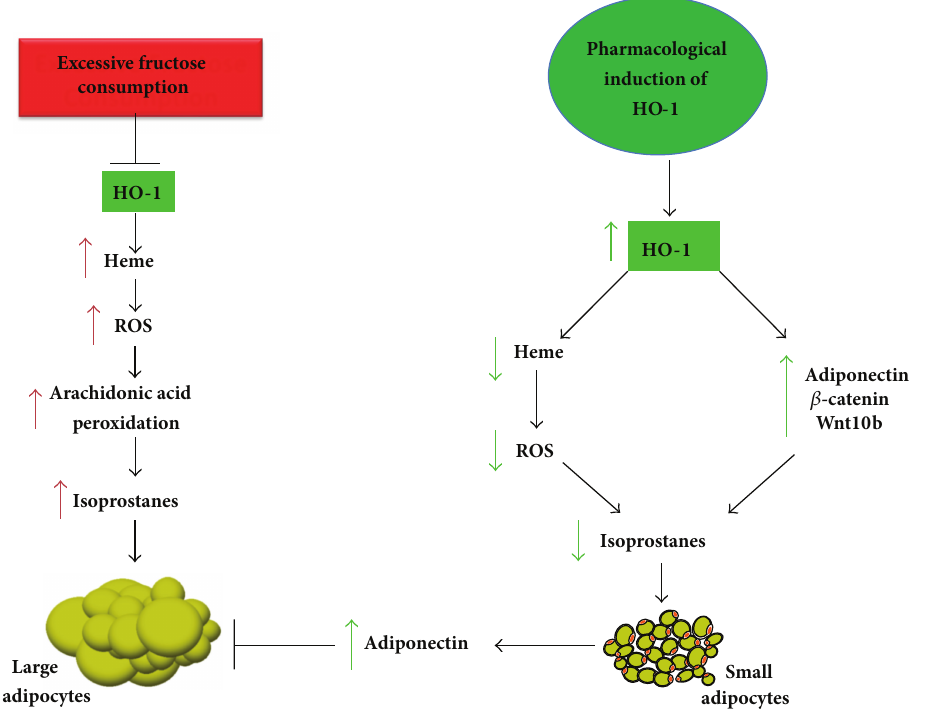
Figure 9: Schematic diagram of fructose-mediated adipocyte expansion and potential mechanisms underlying HO-1-mediated improvement of fructose-induced adipocyte hypertrophy. Excessive fructose consumption is accompanied by decreases in HO-1 gene expression and a concurrent increase in cellular heme levels. Increase in cellular heme results in lipid peroxidation of the essential fatty acid, arachidonic acid, via activation of ROS. The metabolite of this process is isoprostane and, therefore, heme catalyzes isoprostane synthesis. Isoprostane release induces adipocyte hypertrophy and dysfunction. In contrast, the increase in HO-1 expression and HO activity by pharmacological agents, for example, CoPP, leads to a decrease in the cellular heme pool and an increase in the canonical Wnt pathway and of adiponectin. Adiponectin enhances the antioxidant mechanisms, thereby decreasing lipid droplet size along with attenuation of isoprostane production. An increase in HO activity lowers lipid peroxidation, thereby decreasing isoprostane production and diminishing expression of the adipogenic markers Peg-1/Mest, FAS, and aP2, resulting in the lowering of adipocyte hypertrophy. Thus, activation of the HO-1-adiponectin axis along with an increase in the canonical Wnt cascade results in decreased heme (prooxidant) levels and isoprostane production in adipocytes and a decrease in fructose-mediated adipocyte dysfunction and lipid